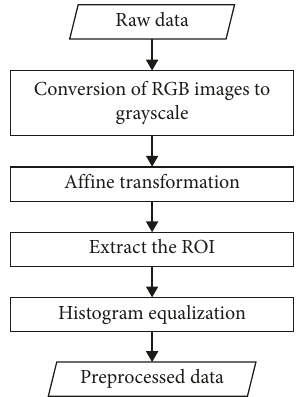
Figure 4: Flowchart for preprocessing images.